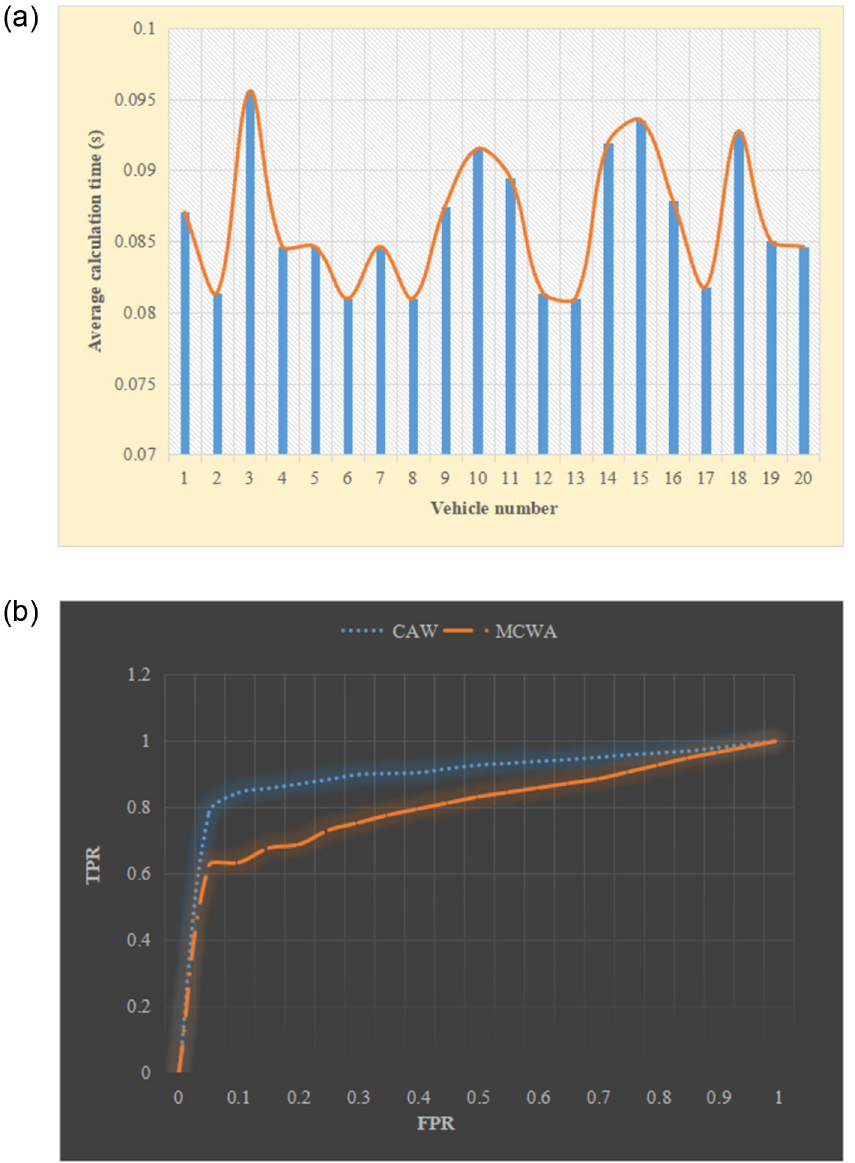
Fig 12. Model training results (a) Average prediction time (b) ROC